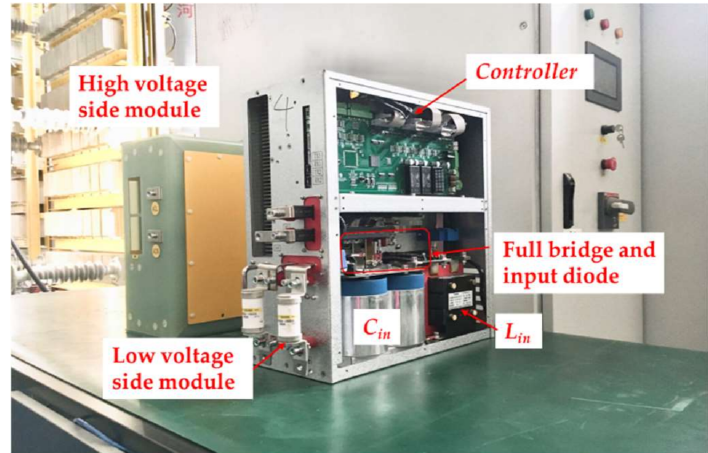
Figure 18. 5 kV/50 kW SiC dc–dc module.